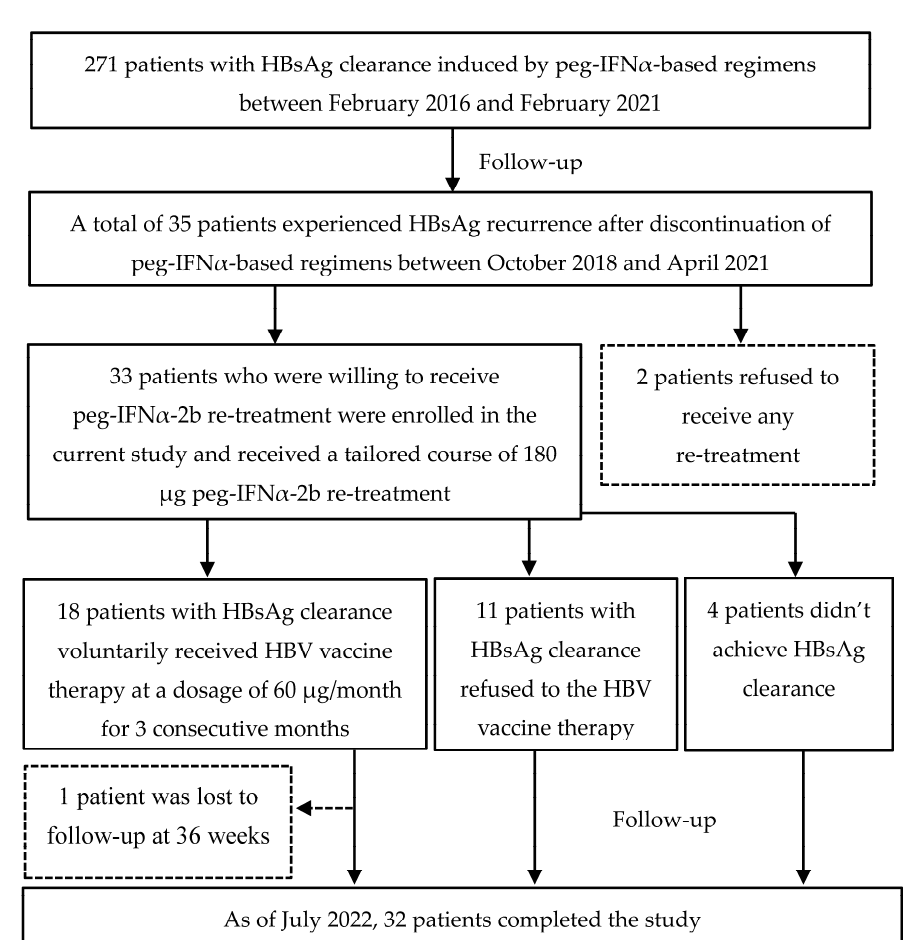
Figure 1. Flow diagram of patients enrolled in this study. (HBsAg, hepatitis B surface antigen; Peg- IFN- α , peginterferon alpha; HBV, hepatitis B